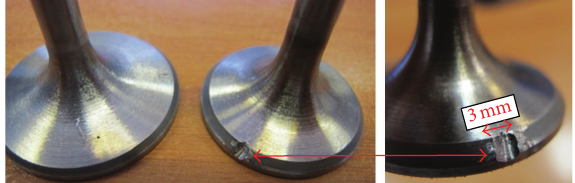
Figure 3: Notched exhaust valve of cylinder number